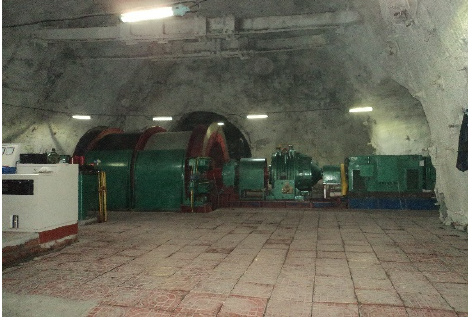
Figure 8. Reinforcement effect of the gangue winch room floor.